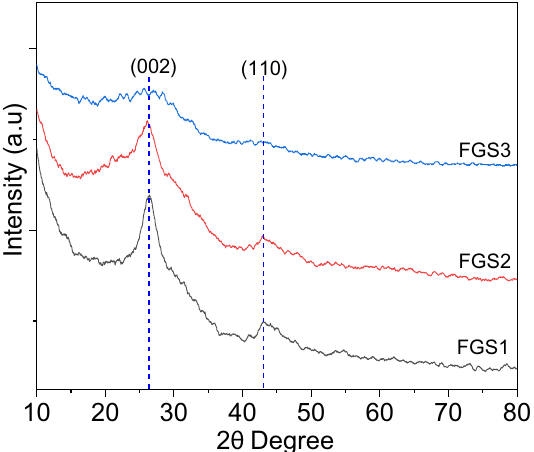
Figure 3. XRD pattern of functionalized graphene oxide/SiO 2